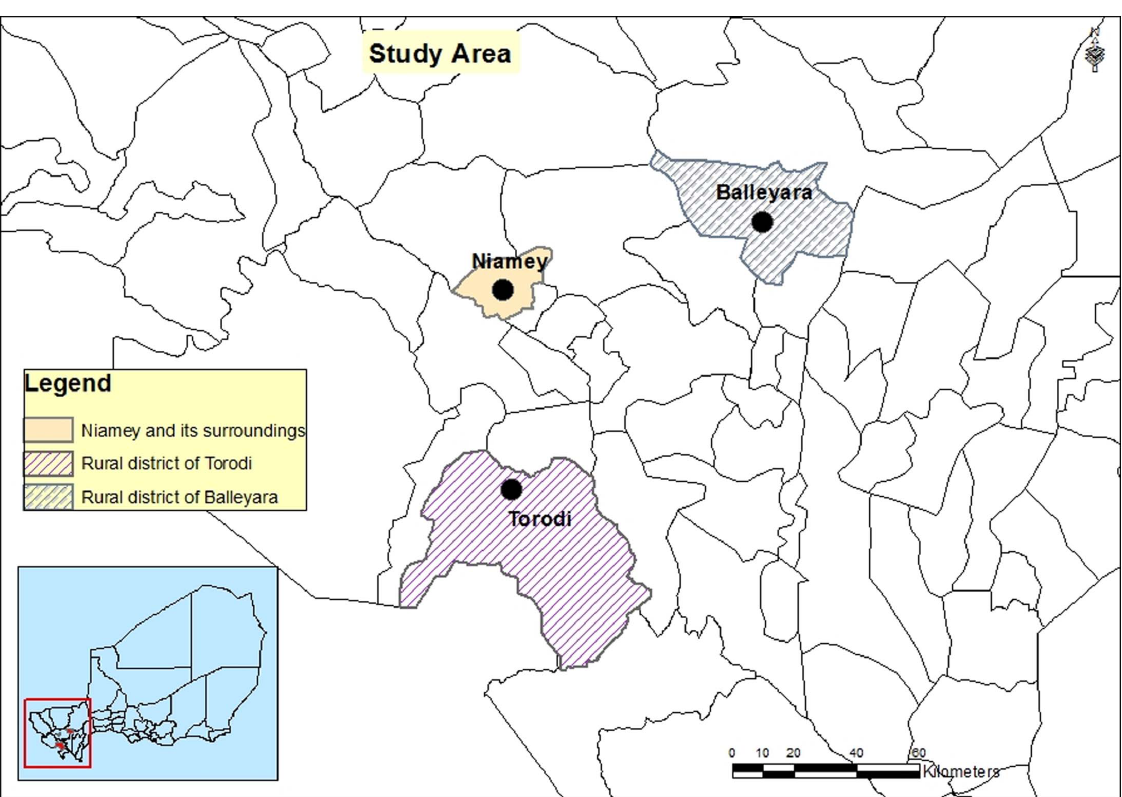
Figure 1. Location of the study areas in Niger.